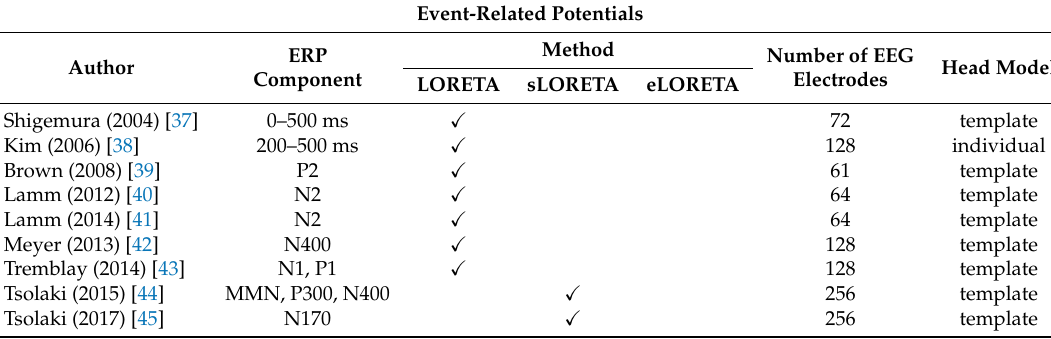
Table 1. Overview of the included papers about event-related potentials